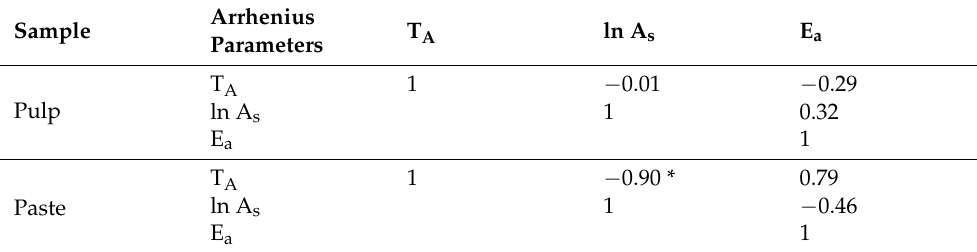
Table 4. Correlation among the defined Arrhenius parameters of currant tomato pulp and paste 1